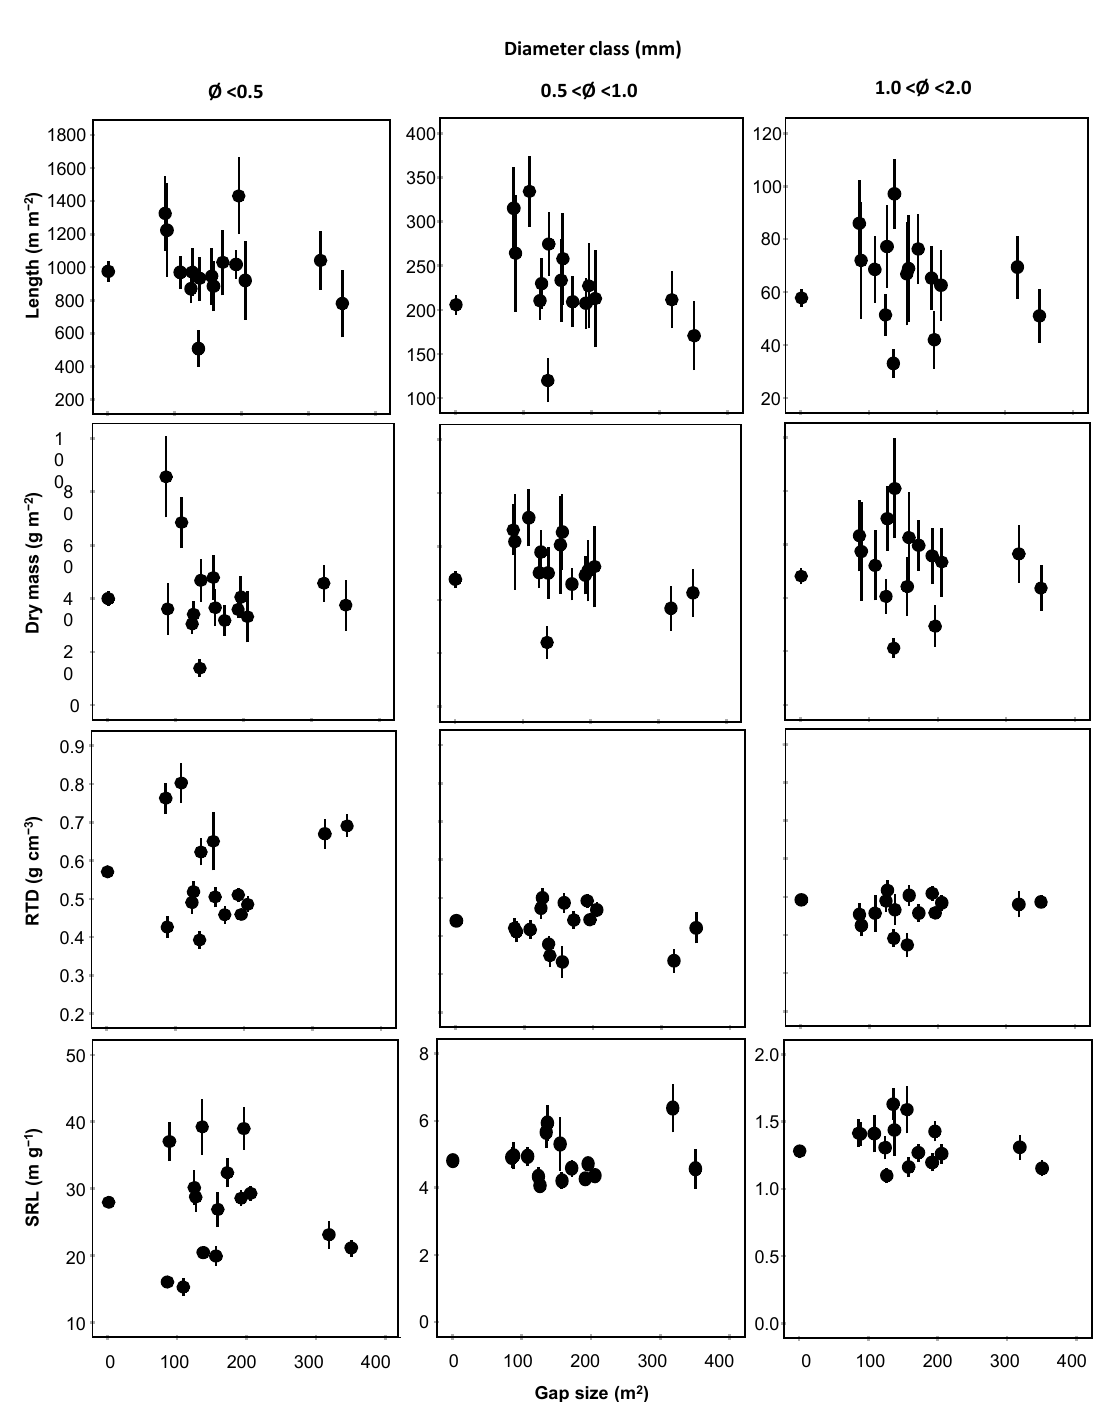
Figure 2. Fine root length, dry mass, root tissue density (RTD), and specific root length (SRL) (columns), according to three diameter classes (<0.5, 0.5–1, and 1–2 mm) (rows), in relation to gap size. Each point represents the mean of 8 replicates (front and back position and orientation pooled together) ± SE. The uncut control was conventionally assigned the gap size value of 1 m 2 and was the mean of 120 replicates (front and back position, orientation, and 15 gap size pooled together). If not reported, the scale for a given variable is the same for all the three panels.